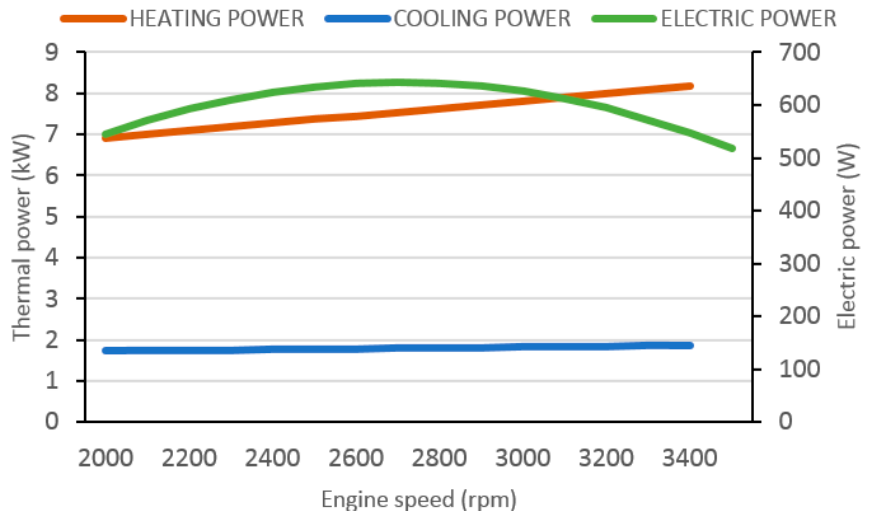
Figure 7. Trigeneration unit schematic experimental performance.